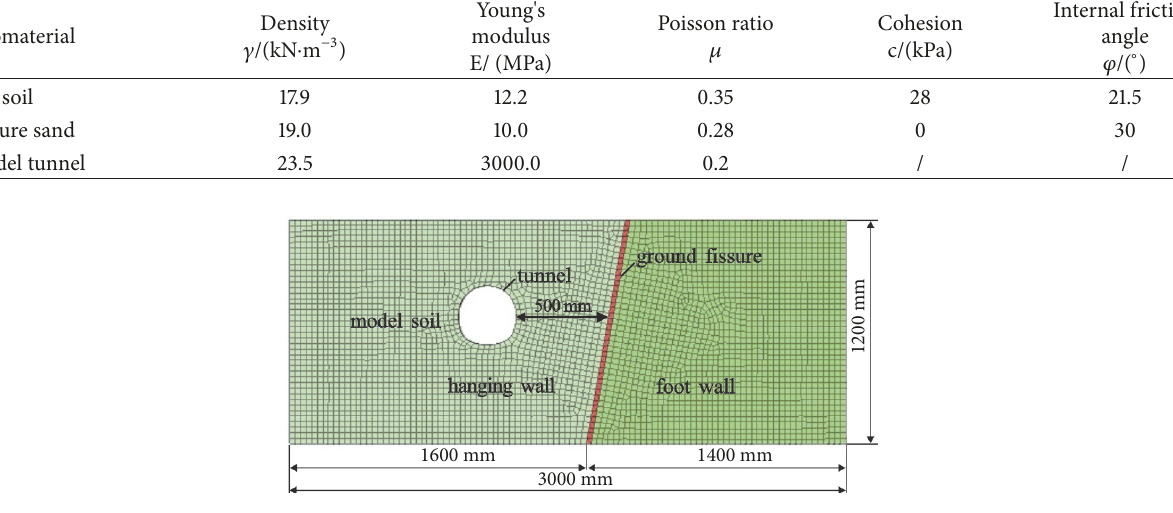
Figure 7: Schematic diagram of numerical